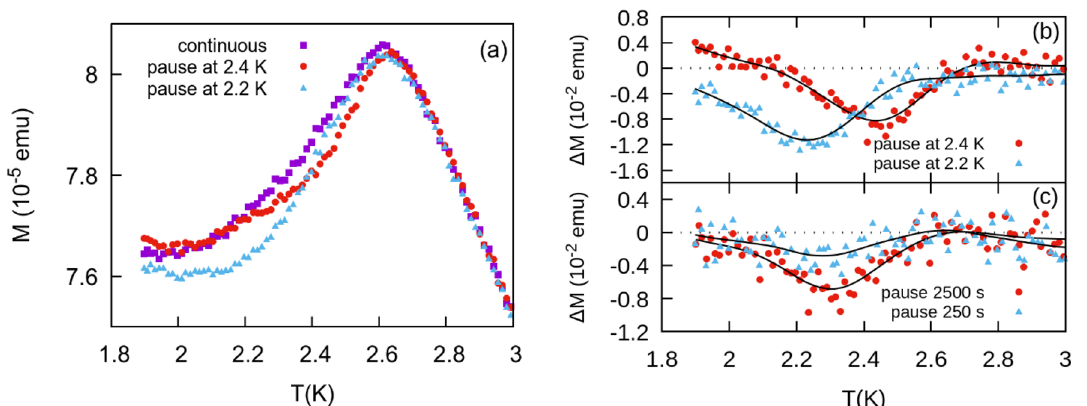
Figure 5. FC magnetization vs time at 1.9 K after a 200 Oe dc field has been removed. t w indicate fits to Eq. (2) .